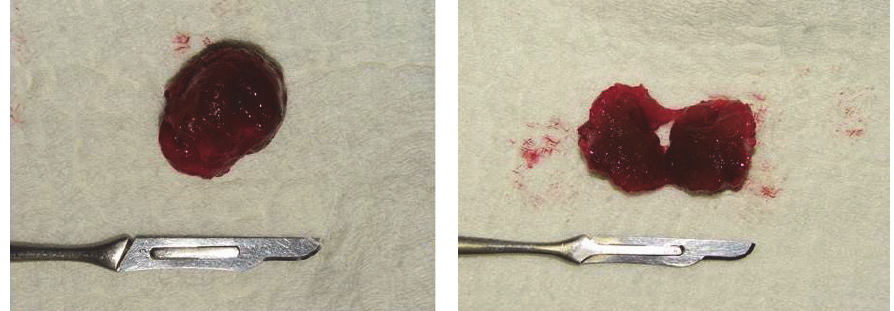
Figure 5: Red-colored and round-shaped nodular lesion.